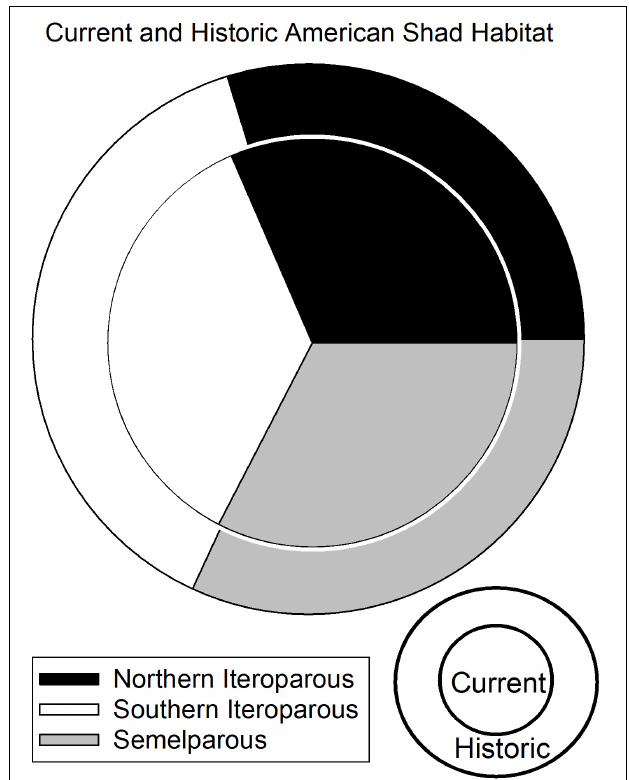
FIGURE 4 | Graphic representation of the Undammed (outer) and Dammed (inner) scenario freshwater spawning habitat available to American shad throughout their native range. The size of the circles is proportional to the area of historic unimpounded habitat (2,752 km 2 ) and current habitat access (1,639 km 2 ), indicating that American shad are impeded from reaching nearly 41% of their historic